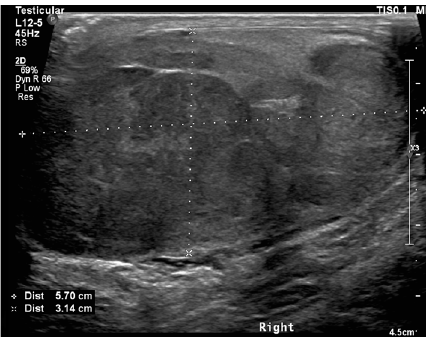
Figure 1: Ultrasound of right testicle.